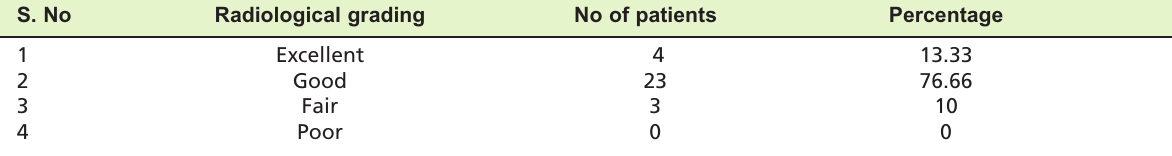
Rasmussens radiological Table III: